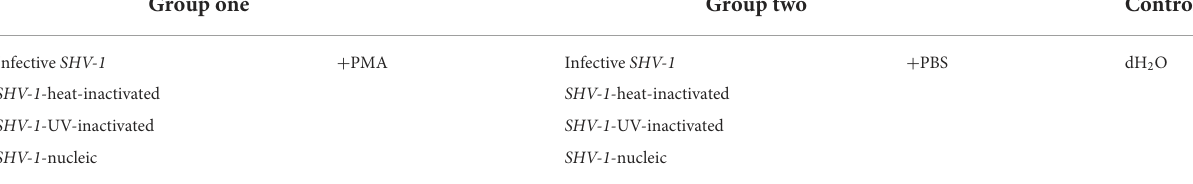
TABLE 1 Propidium monoazide (PMA) treatment groups and controls.